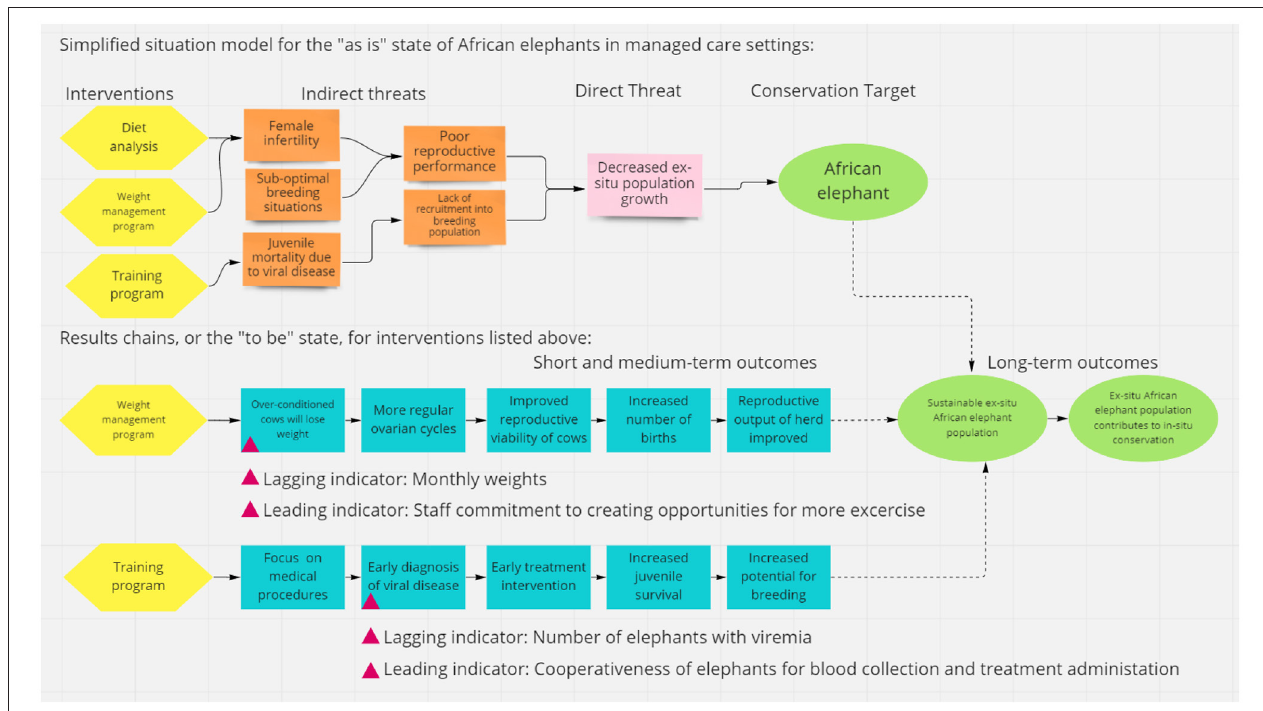
FIGURE 1 | Example of a theory of change model including a situation model, results chains, and lagging and leading indicators created using